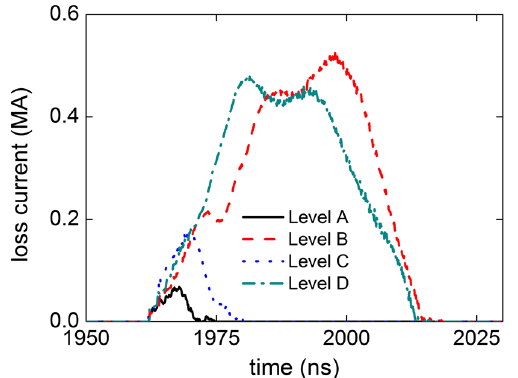
FIG. 10. Impedance profiles for level A to D in the transmission direction. The x axis is the sequence number of MITL elements. All four levels have a section with uniform impedance. Levels A (the black solid) and C (the red dash) have lower impedance in general. Level C (blue dotted) and level D (dash dotted dark cyan) have longer electric